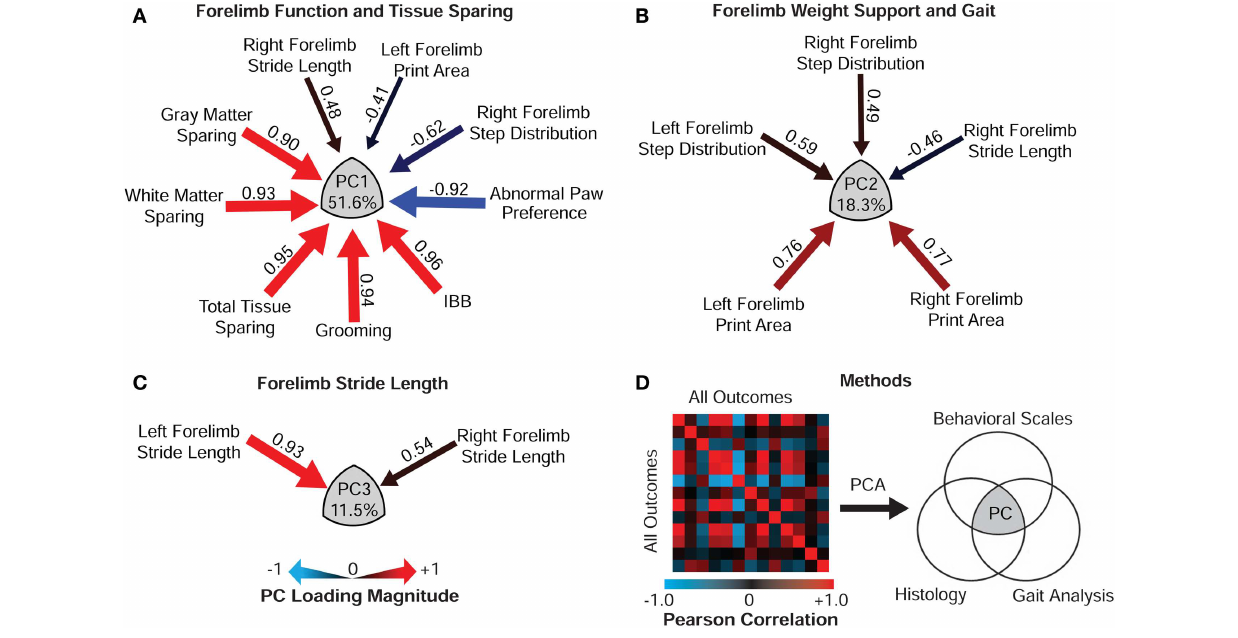
FIGURE 12 | Construct validity of the IBB Score . Principal component analysis (PCA) extracted three orthogonal multivariable principal component (PC) clusters that together accounted for 81.4% of the variance in outcome after SCI. (A) PC1, the largest cluster of variance (51.6%) reflects the relationship between forelimb function and histological outcome. Note the IBB score is the highest loading variable on PC1, providing evidence of construct validity. (B) PC2 (18.3% variance) reflected the relationship of forelimb weight support and gait.